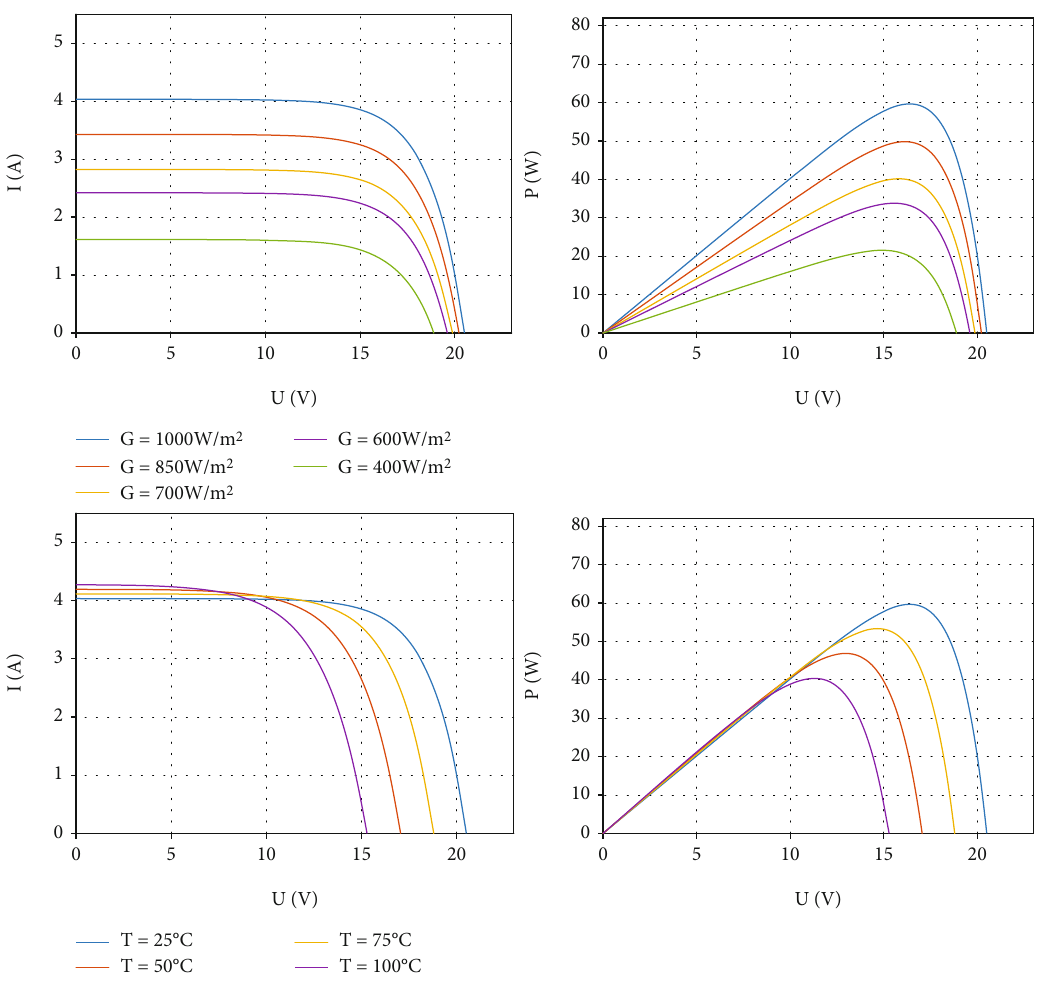
Figure 2: Characteristic I-V and